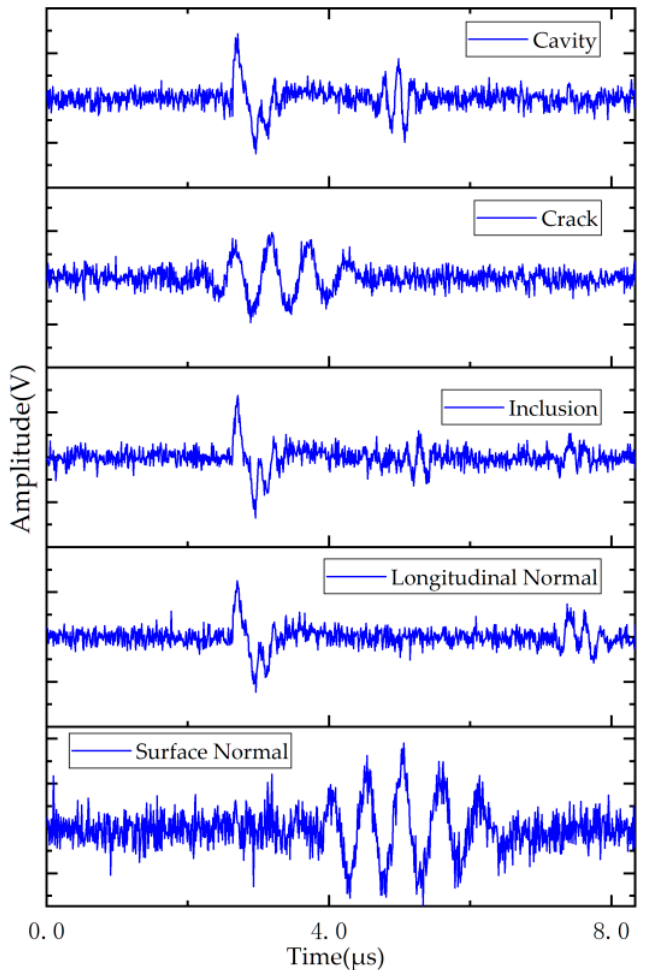
Figure 9. Echo signals from the specimen of interest.